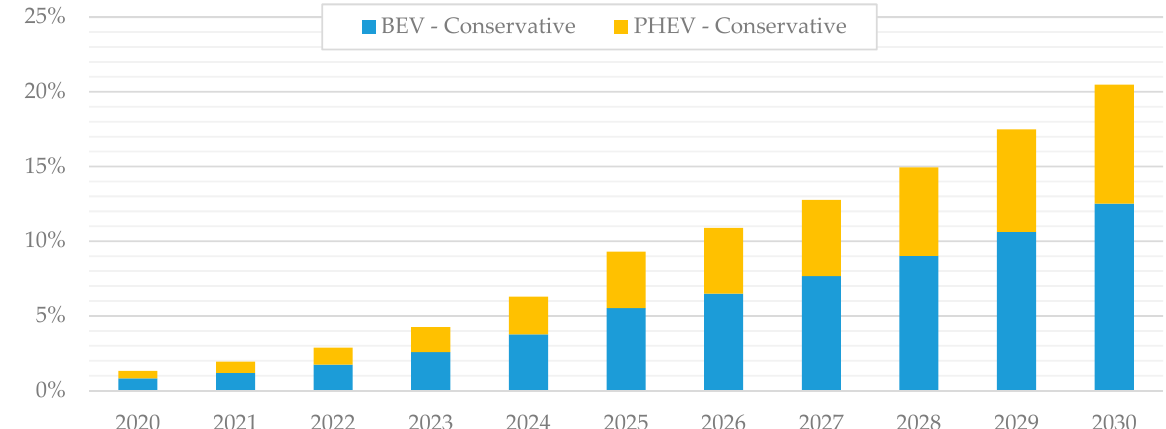
Figure 5. Estimated average BEV and PHEV penetration index on car sales from 2020 to 2030 at Italian level (conservative scenario).